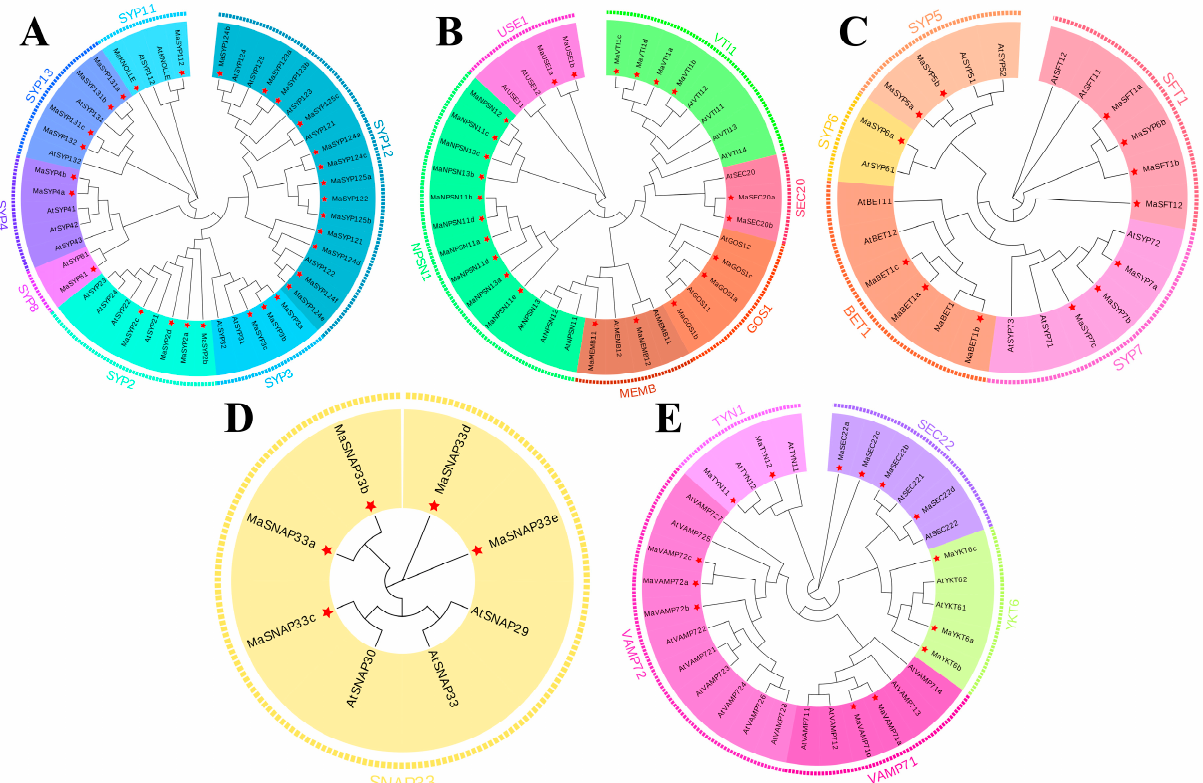
Figure 1. Phylogenetic trees constructed using Qa-SNARE ( A ), Qb-SNARE ( B ), Qc-SNARE ( C ), Qbc-SNARE ( D ), and R-SNARE ( E ) subfamily members from Musa acuminata (Ma) and Arabidopsis thaliana